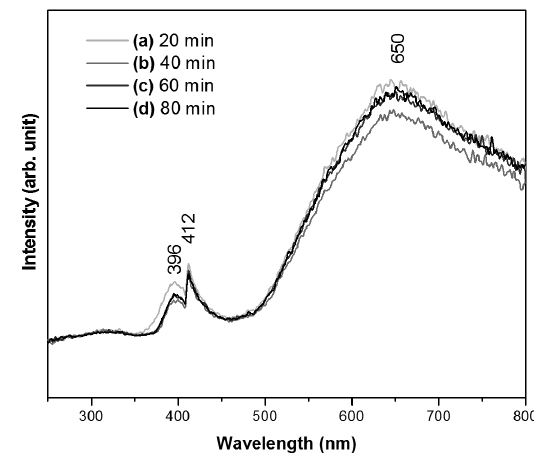
Figure 7. FTIR spectra of samples: (a) G1, (b) G2, (c) G3 and (d) G4. Figure 8. PL spectra of samples: (a) G1, (b) G2, (c) G3 and (d)